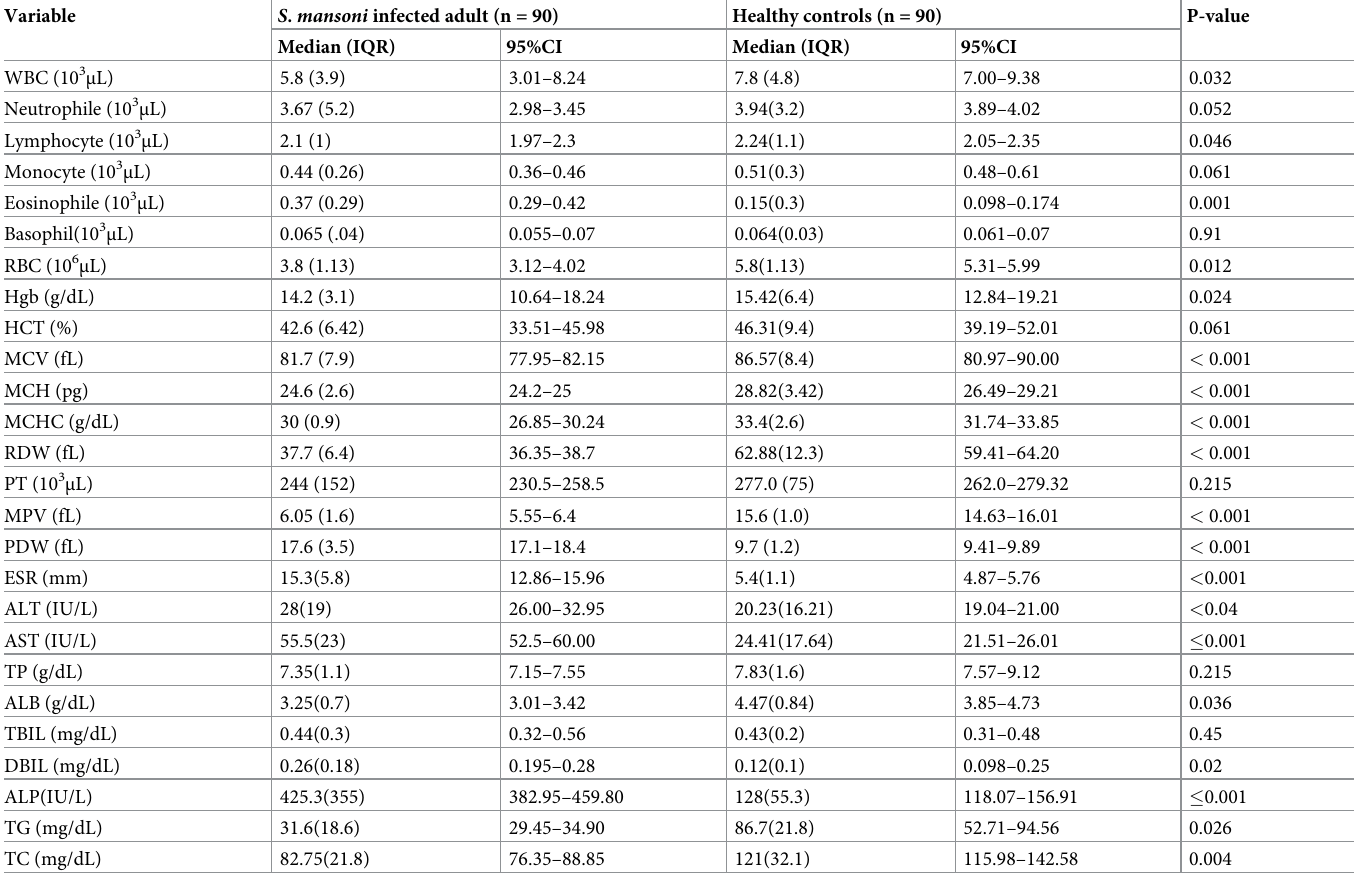
Table 4. Comparison of hematological and biochemical profiles among S . mansoni infected adults and apparently healthy controls at Haik Primary Hospital, North-East Ethiopia from February to April 2021.